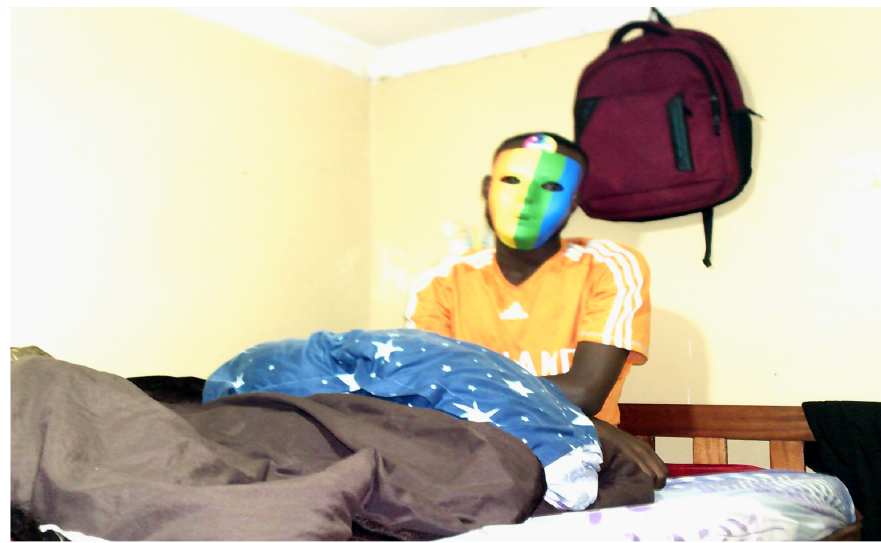
Figure 4. A bunk bed in the three-bedroomed community house used to create space and accommodate more people.